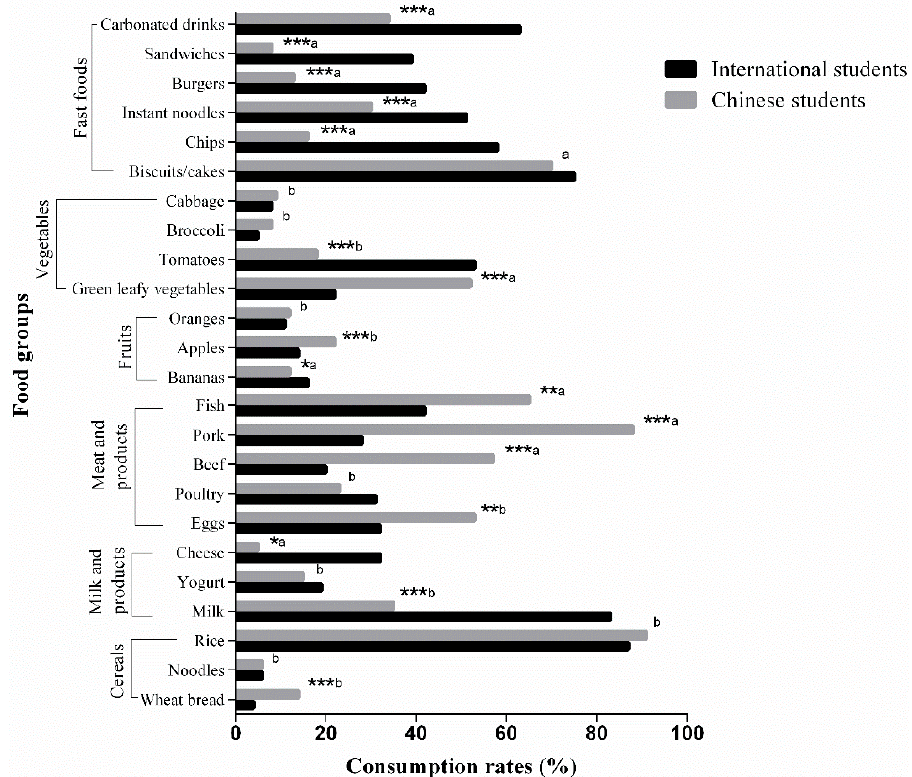
Figure 2. Comparison of dietary intake between international and Chinese students. Dietary intakes between international and Chinese students were on weekly basis. * indicates p < 0.05, ** indicates p < 0.01, *** indicates p < 0.001, a = 1 time/week, b = 7 times/week. χ 2 -test was used for comparison.